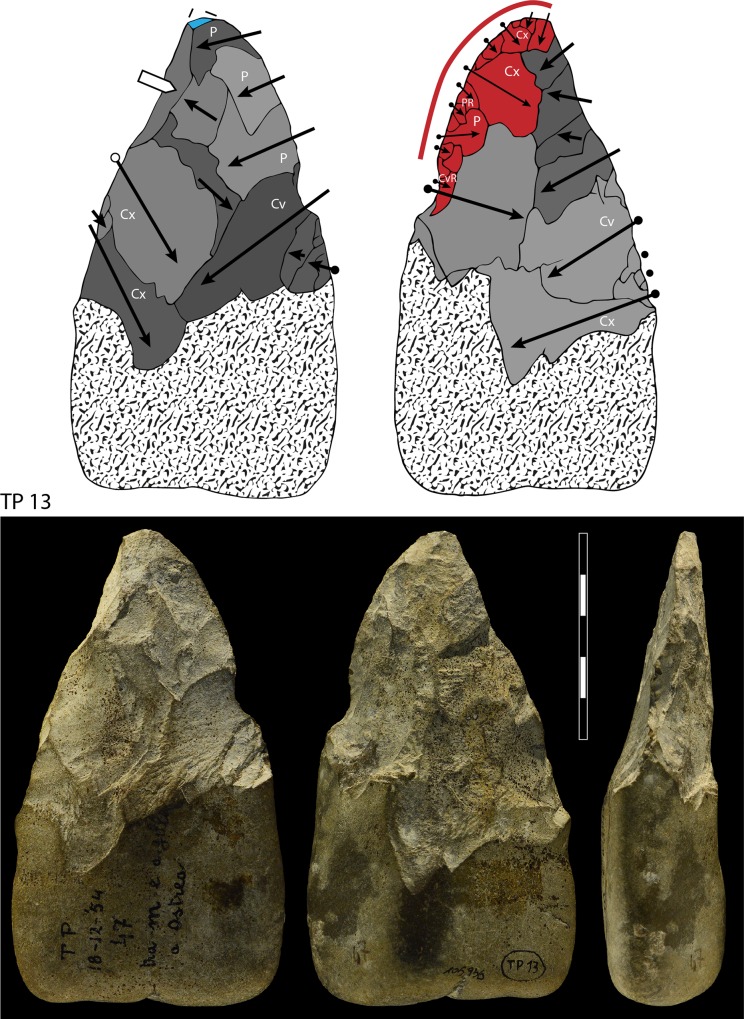
TP 13, limestone.Symbols in drawing as in Fig 10.